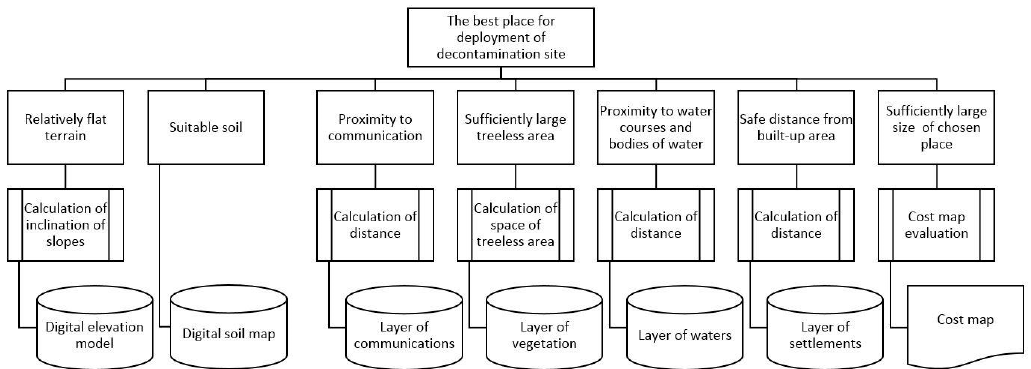
Figure 4. Scheme of the selection process model of a suitable place for decontamination site deployment.